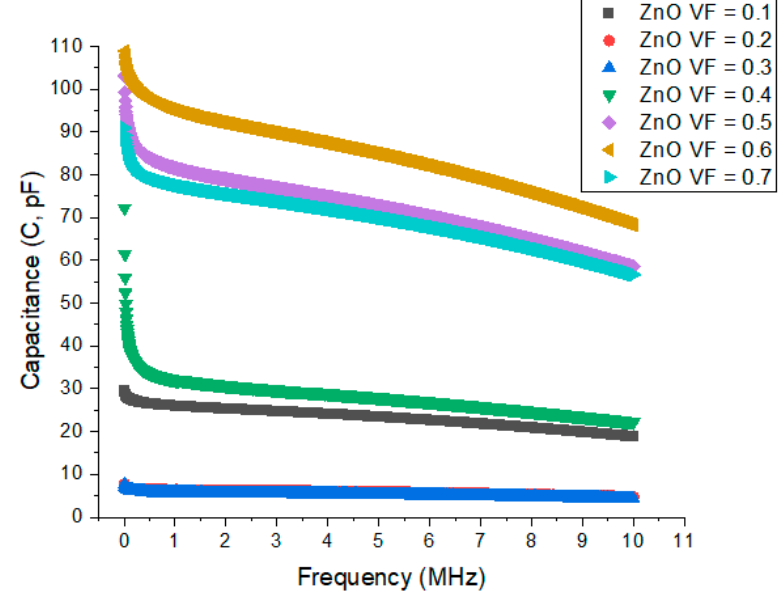
Figure 6. Variation of the Capacitance spectrum for the nanocomposite samples for di ff erent volume fractions of ZnO with a change of frequency from 20 Hz–20 MHz.